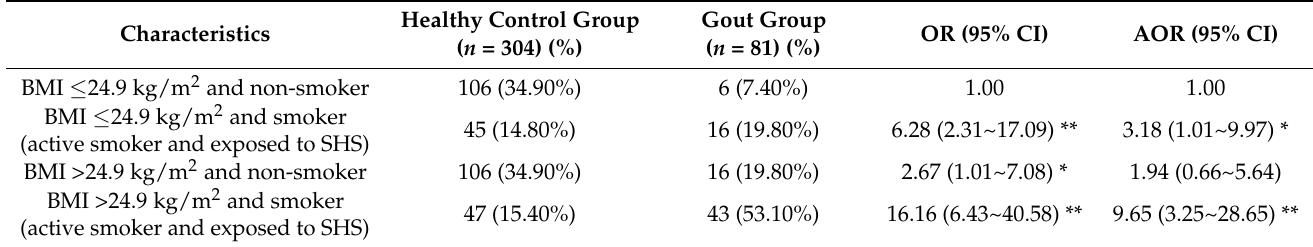
Table 4. Synergistic effect between BMI and smoking status on the risk of gout ( N = 385). Characteristics